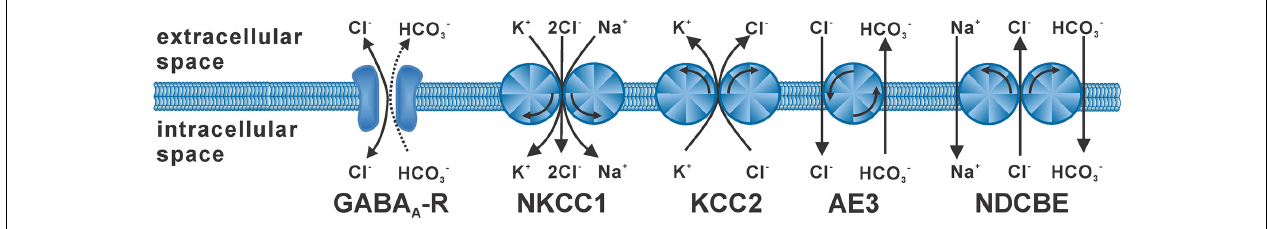
FIGURE 1 | Stoichiometry and typical operation of secondary active Cl − transporters. The GABA A receptor (GABA A -R) mediates mainly Cl − fluxes and to a lesser extent HCO 3 − fluxes. NKCC1 mediates uptake of two Cl − ions with of one K + and one Na + ion. KCC2 mediates extrusion of one Cl − with one K + ion. The anion-exchanger (AE3) is supposed to mediate uptake of one Cl − ion in antiport with one HCO 3 − ion. The Na + -dependent Cl − /HCO 3 − exchanger (NDCBE) utilizes the Na + gradient to extrude Cl −